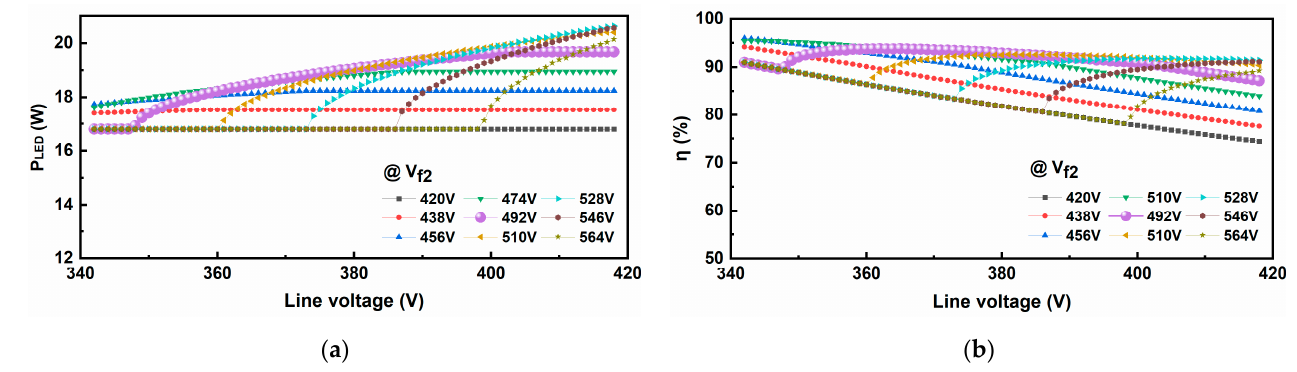
Figure 4. ( a ) LED power and ( b ) drive efficiency in double-string GaN LED driving scheme.